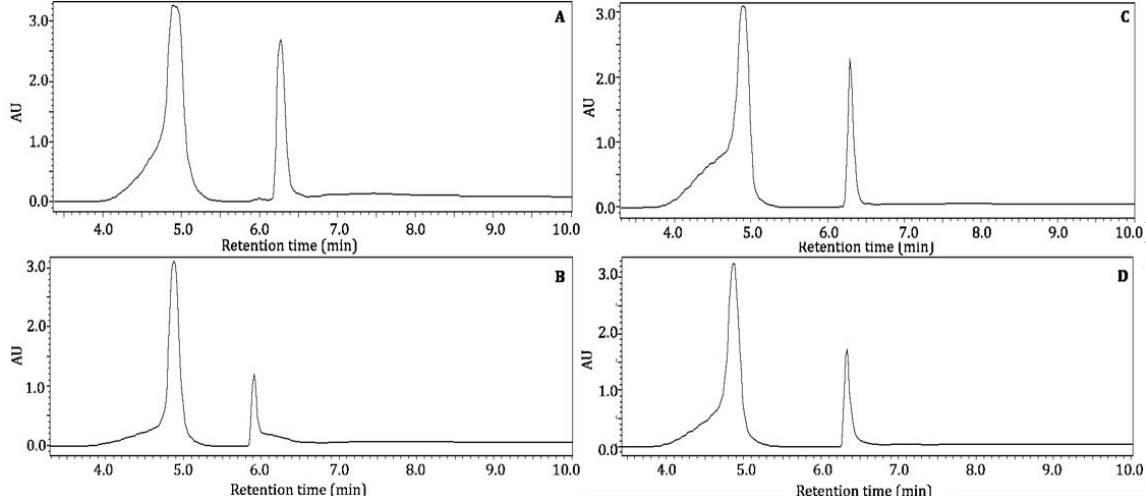
Figure 2. Bioactive profile of crude pecan shell Nacono extracts by reverse phase high performance liquid chromatography (RP-HPLC). Hyphenated chromatograms (3.5–12.2 min) by HPLC of crude pecan shell Nacono extracts. A 50 µL volume of methanol soluble components was injected into a c18 column, eluted with a binary mobile phase, and detected with a UV/VIS diode array absorbance detector. The chromatograms represent detection at the 280 nm wavelength channel. Pe- can shells were subjected to solid-liquid extraction (20 g -L ) with distilled water at 98 °C for 1 h ( A ) or ethanol at 22 °C for 1 h ( B ) under constant mixing.